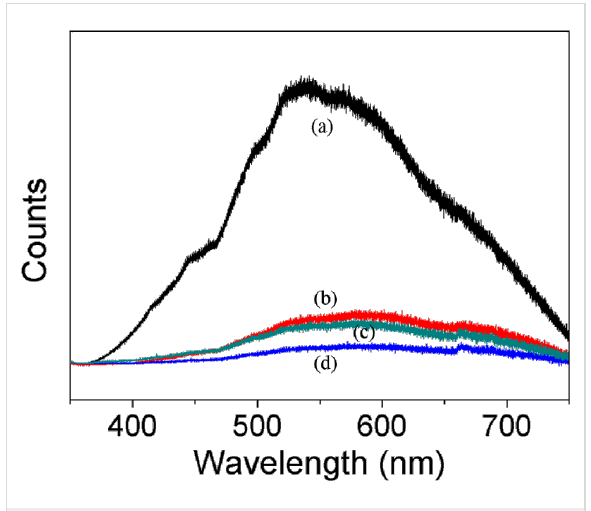
Figure 8: Photoluminescence spectra of a) TiO 2 , b) 0.5 wt % Pd/TiO 2 , c) 3.0 wt % Pd/TiO 2 and d) 1.0 wt % Pd/TiO 2 .